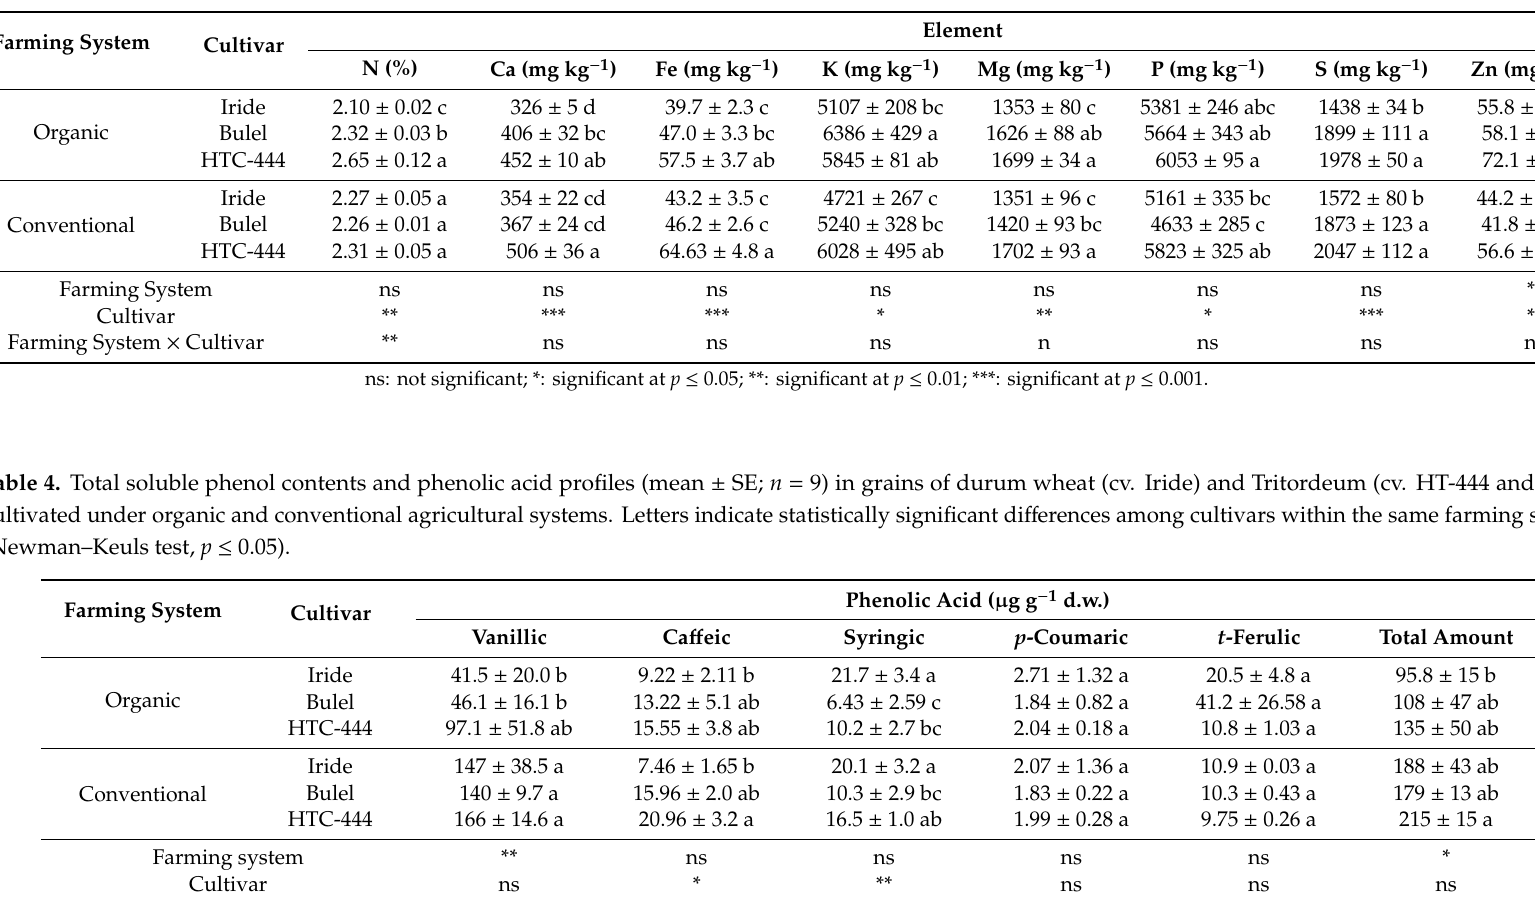
Table 3. Mineral concentrations (mean ± SE; n = 9) in grains of durum wheat (cv. Iride) and Tritordeum (cv. HTC-444 and Bulel) cultivated under organic and conventional agricultural systems. Letters indicate statistically significant di ff erences among cultivars within the same farming system (Newman–Keuls test, p ≤ 0.05).